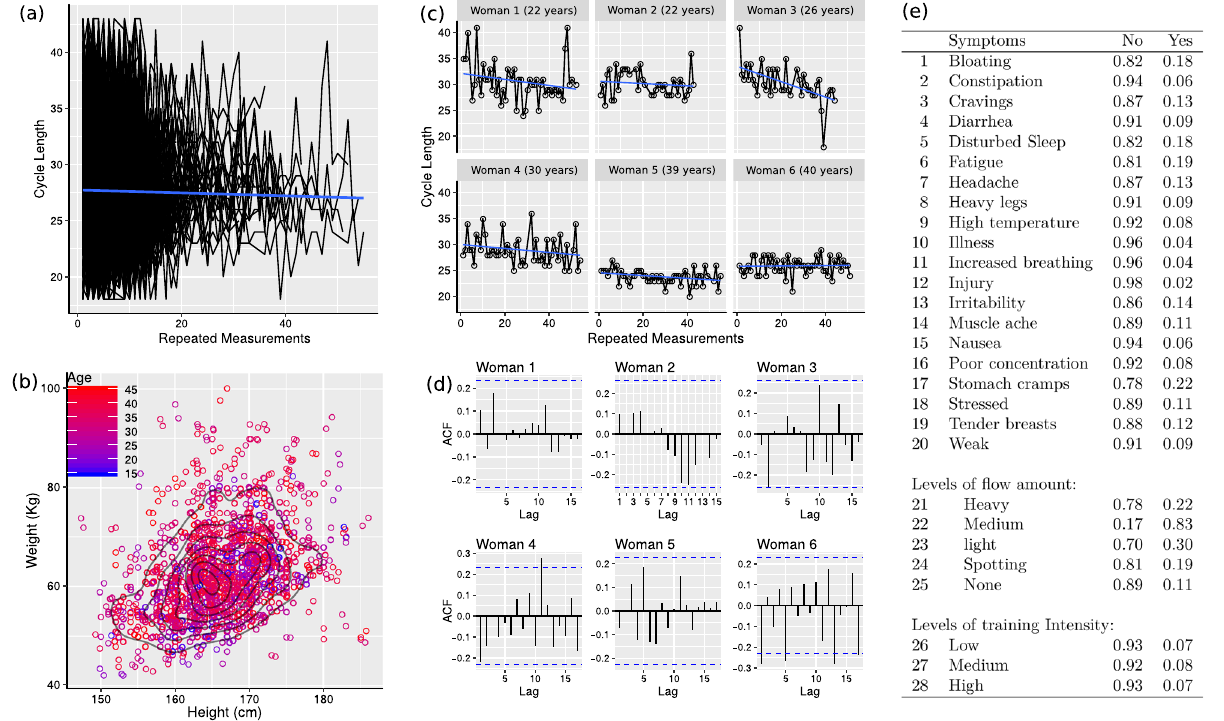
Figure 7. ( a ) Individual profiles of 2125 women over time; ( b ) Bivariate density plot of weight and height given age; ( c ) Individual profiles for a sample of six women with linear trend superimposed; ( d ) autocorrelation plot; ( e ) Proportion of symptoms reported, where the label “Yes” is related with “the event was reported at least one time” and “No” Statistical analysis. Let Y ij be a random variable, representing the length of menstrual cycle, where y ij represents the observed cycle length for the i -th woman, i = 1, 2, . . . , I for her j -th menstrual cycle where j = 1, 2, . . . , J i . The main objective is to derive the one-step ahead predictive distribution given by